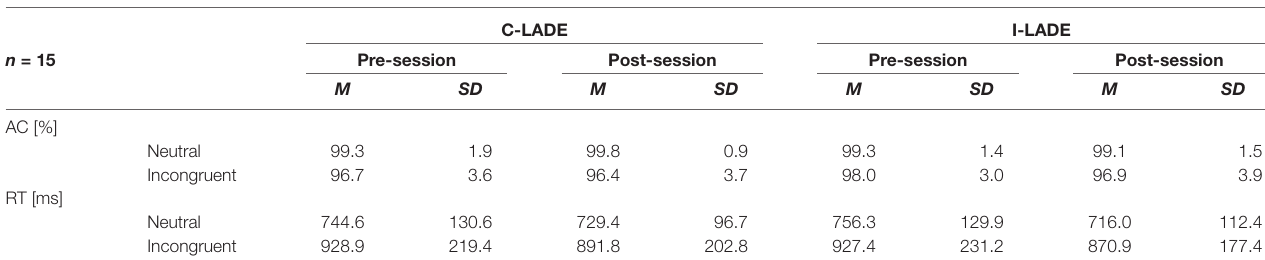
TABLE 2 | Behavioral data based on the